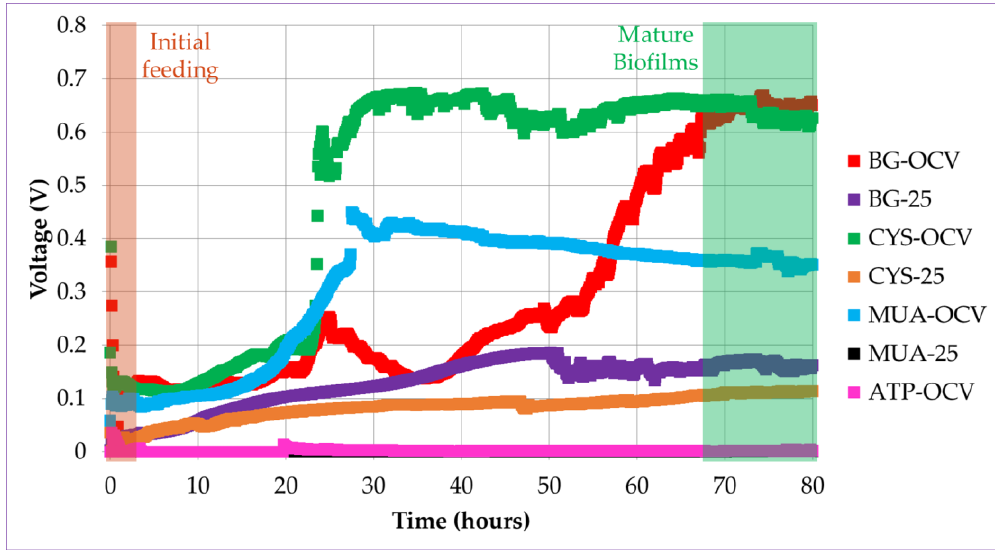
Figure 6. Voltage versus time plots for different µMFC systems during the start-up period (the voltage for the MUA-25 system was close to ATP-OCV).